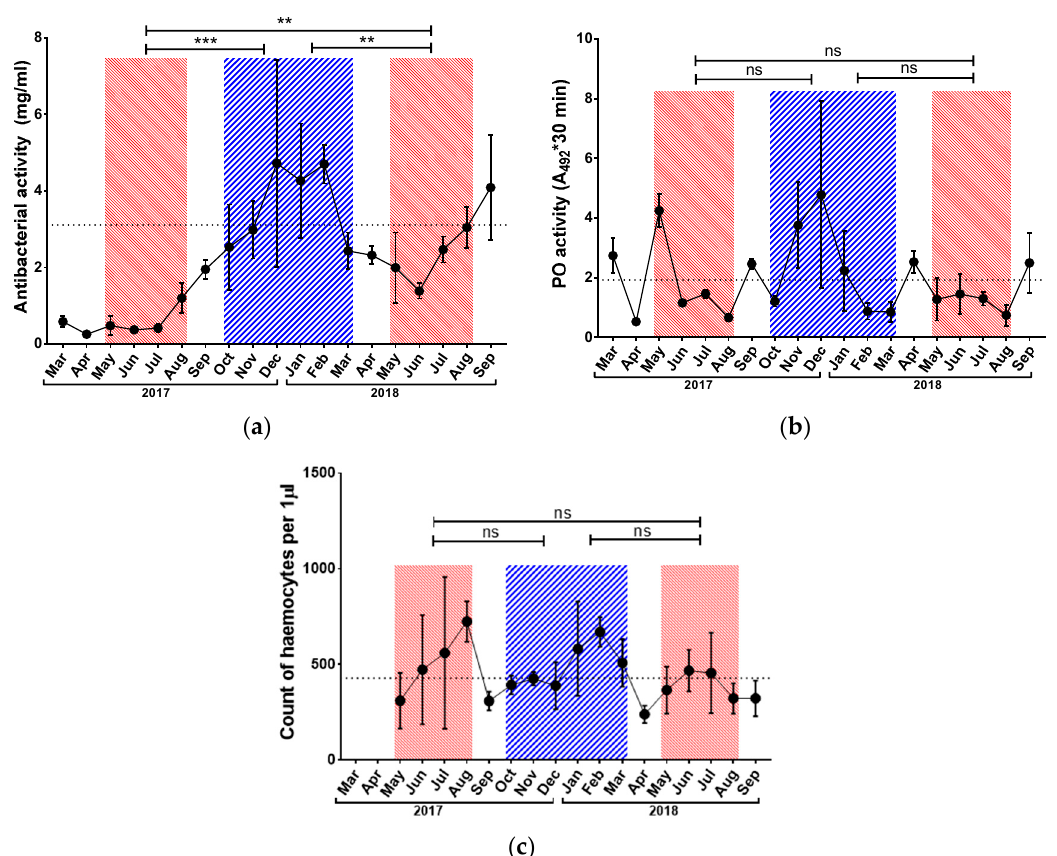
Figure 2. Seasonal development of antibacterial activity ( a ), the activity of phenoloxidase ( b ) and haemocytes counts ( c ) in honey bee haemolymph. Red striped areas indicate summer generations of honey bees (May–August), and blue area indicates winter generation (October–March). Dots represent mean ± SD, n = 3–5. Dotted line represents annual average (October 2017–September 2018). Asterisk indicates significant difference ** p < 0.01, *** p < 0.001, ns = not significant.